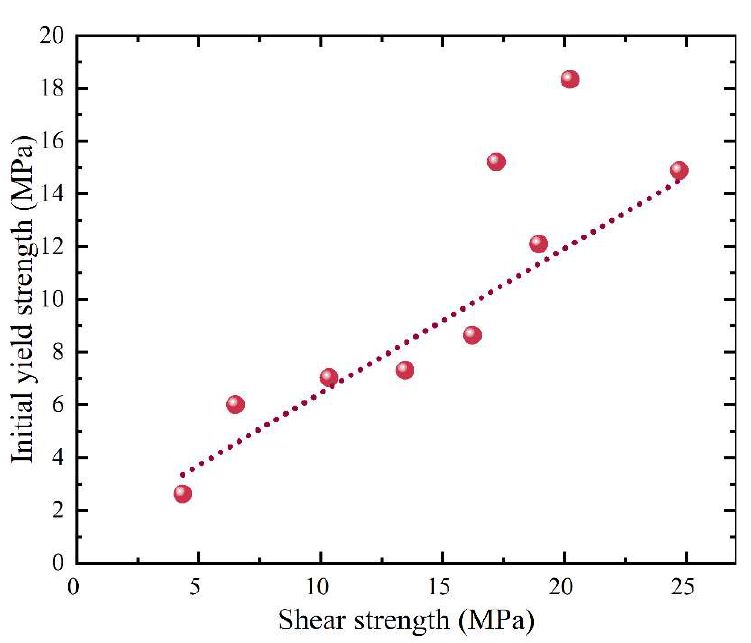
Figure 10. The relationship between initial yield strength q 0 and shear strength q f .